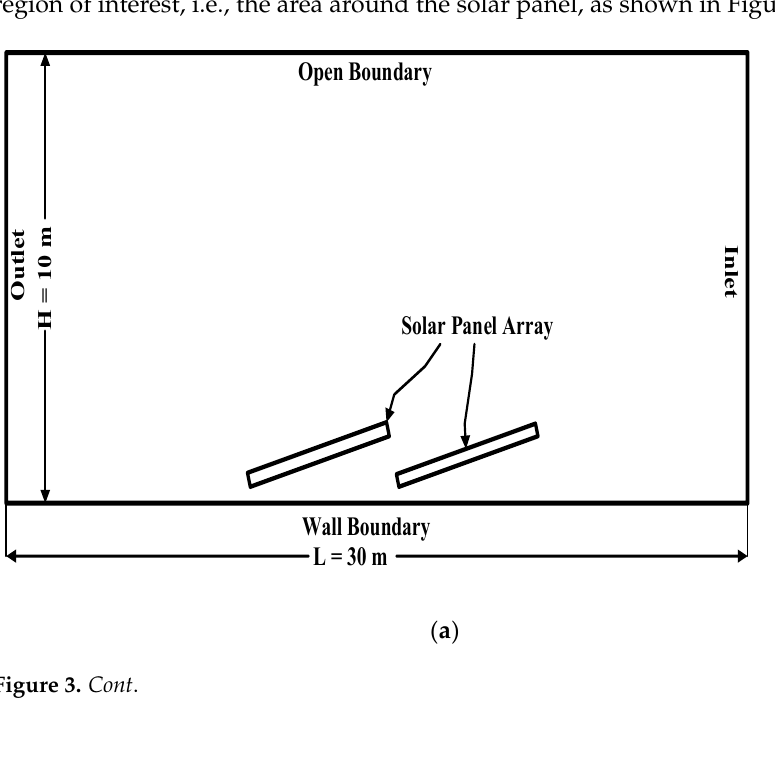
Table 2. Grid Independence Study .